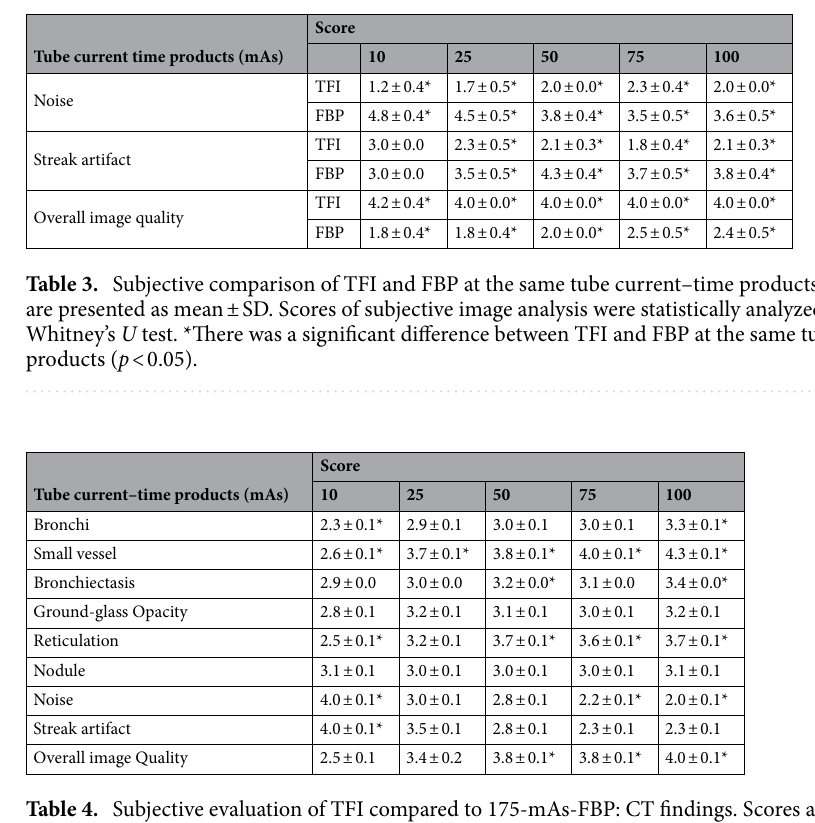
Table 4. Subjective evaluation of TFI compared to 175-mAs-FBP: CT findings. Scores are presented as mean ± SD. Scores were statistically analyzed using two-way ANOVA and the Bonferroni test as post-hoc test to compare the scores of TFI images at five different tube current–time products (10-, 25-, 50-, 75-, and 100- mAs) with the scores of 175-mAs-FBP images. Scores of 175-mAs-FBP are 3 point. *There was a significant difference between TFI and 175-mAs-FBP ( p < 0.005).